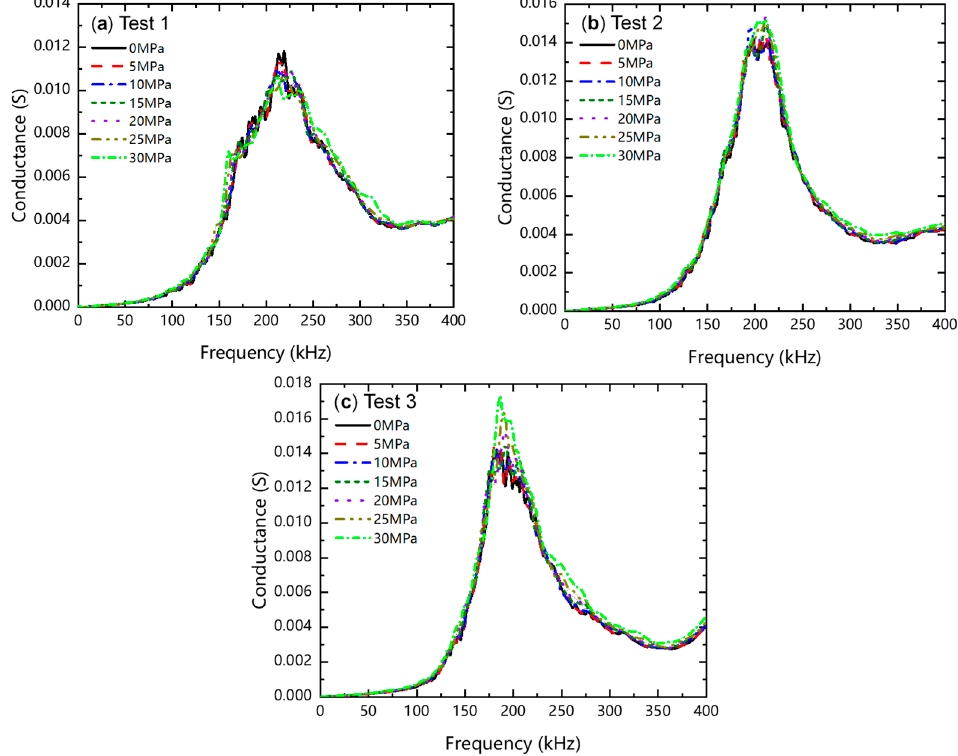
Figure 13. Conductance signatures obtained from the experimental tests in concrete cubes with the 90° rough PZT sensors. 90 ◦ rough PZT